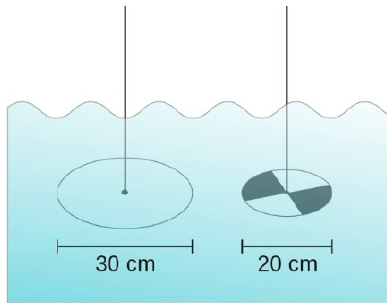
Figure 3. Two different kinds of Secchi disks [183].